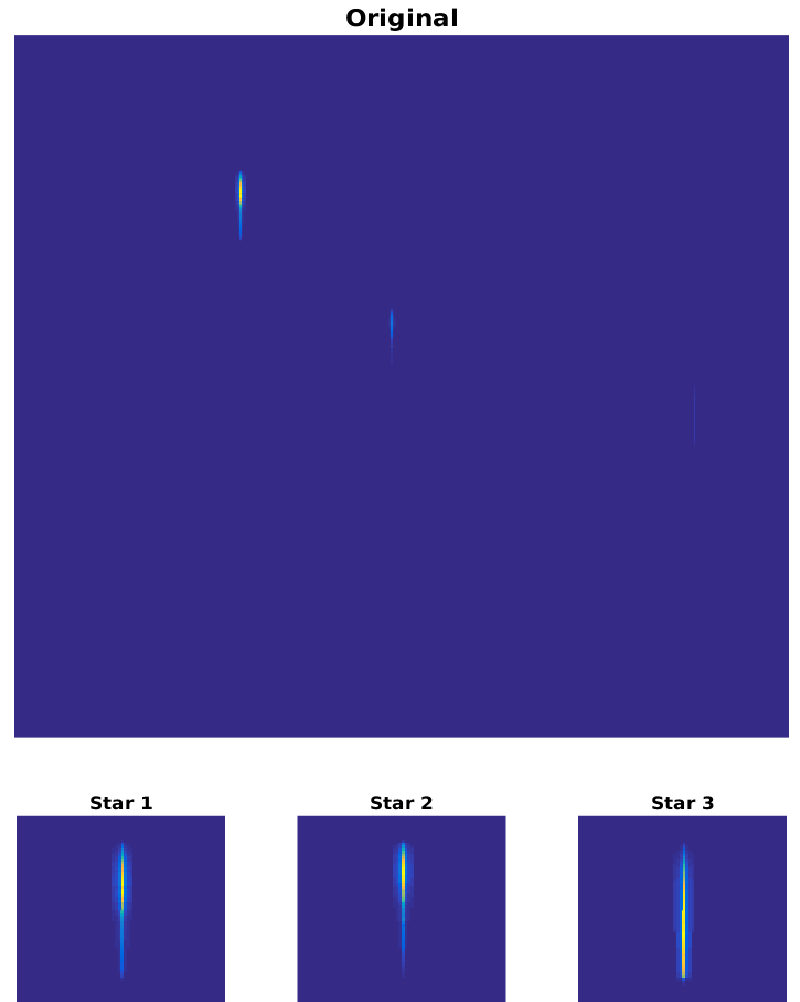
Figure 9. Simulated image in counts with a detail of the spectrum obtained for each of the three simulated stars.